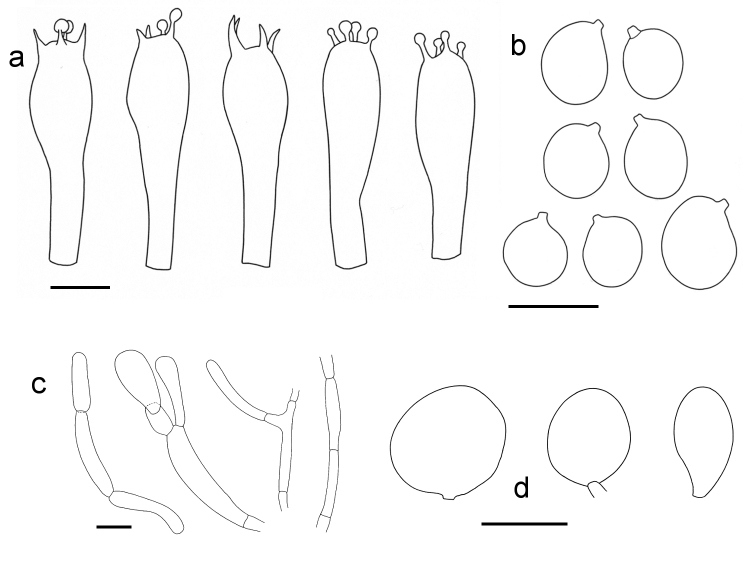
Amanitaharkoneniana (all from Saarimäki et al. 1061, holotypus) a Basidia (scale bar: 10 µm) b Spores (scale bar: 10 µm) c Filamentous hyphae from the volva (scale bar: 20 µm) d Sphaerocysts from the volva (scale bar: 50 µm).